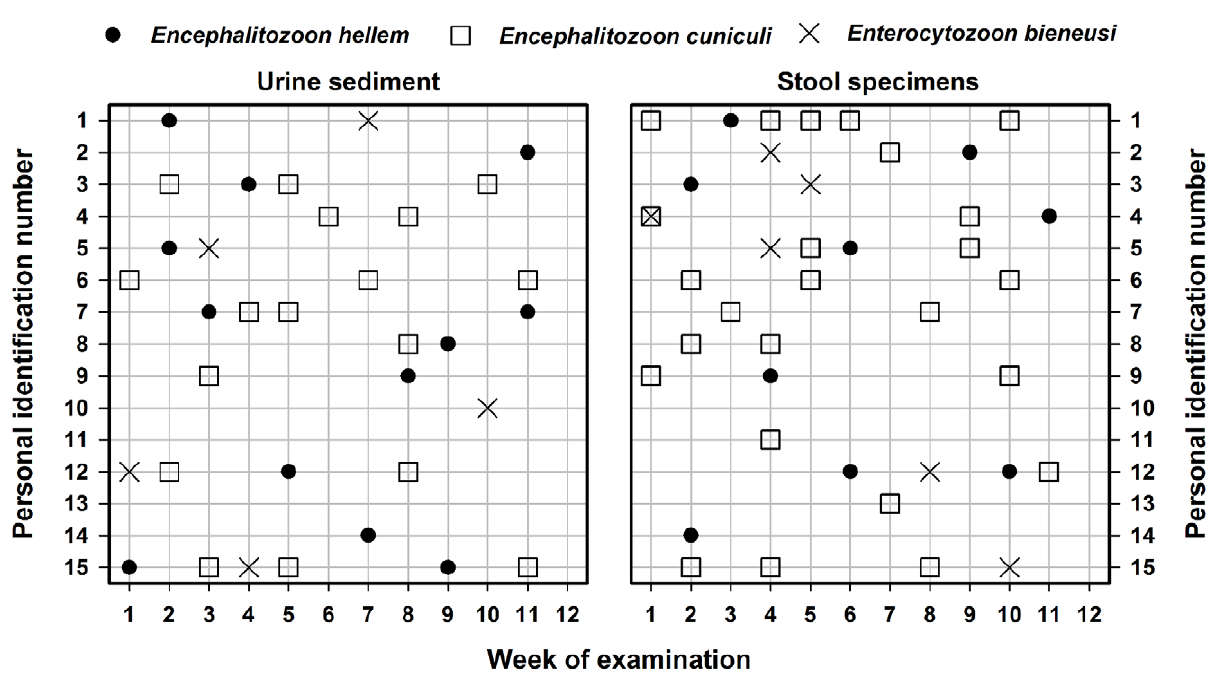
Figure 1. Frequency of microsporidia excretion by naturally infected immunocompetent humans. A urine sediments; B stool samples.